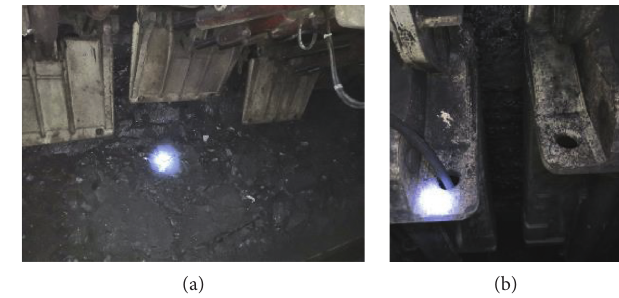
Figure 2: (a) Rib spalling and (b) roof falling on site.